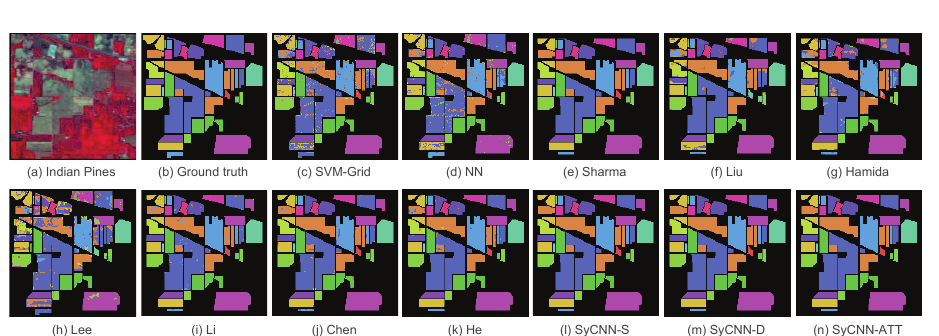
Figure 8. Visualization of the experimental results based on Indian Pines: ( a ) Indian Pines, ( b ) Ground truth, ( c ) SVM-Grid, ( d ) NN, ( e ) Sharma, ( f ) Liu, ( g ) Hamida, ( h ) Lee, ( i ) Li, ( j ) Chen, ( k ) He, ( l ) SyCNN-S, ( m ) SyCNN-D, ( n ) SyCNN-ATT. It is observed that the outputs produced by our proposed models are quite close to the Ground